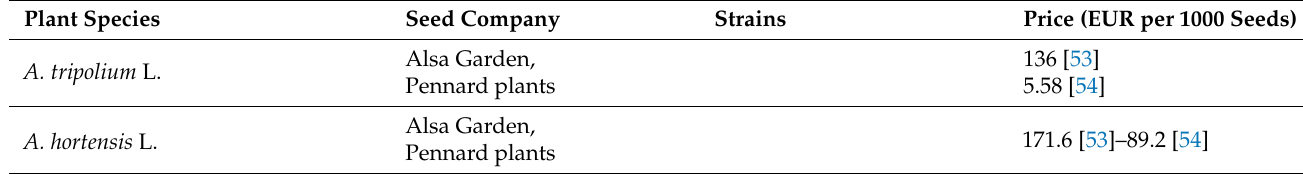
Table 4. Selected strains, price, and seed companies that sell the seeds of the considered plant